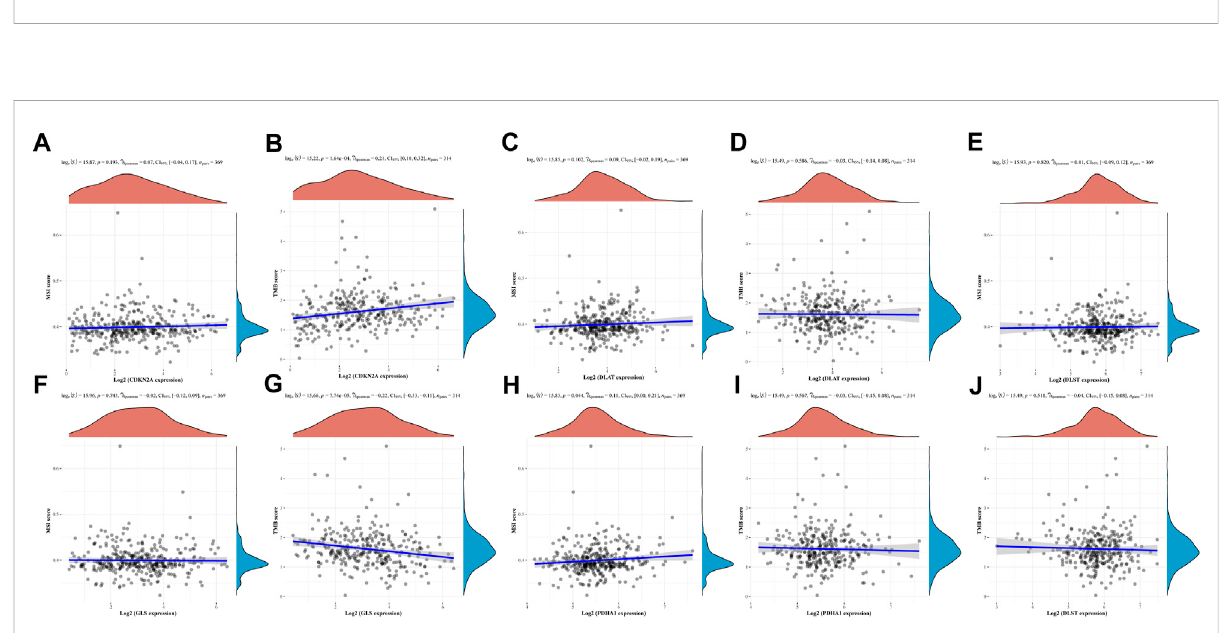
FIGURE 9 TMB, MSI analysis of CRGs in HCC (A,C,E,F,H) Correlation between fi ve prognostic CRGs and TMB. (B,D,G,I,J) Correlation between fi ve prognostic CRGs and